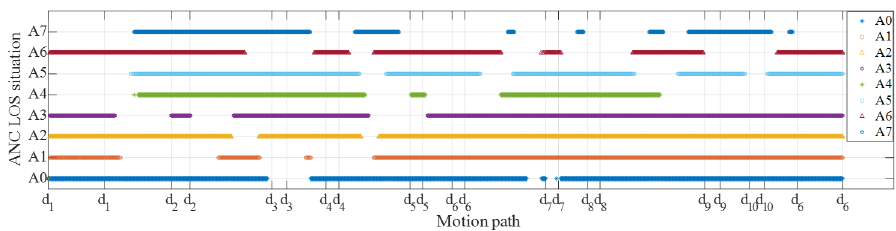
Figure 13. LOS selection of each anchor under the path of Experiment 1.